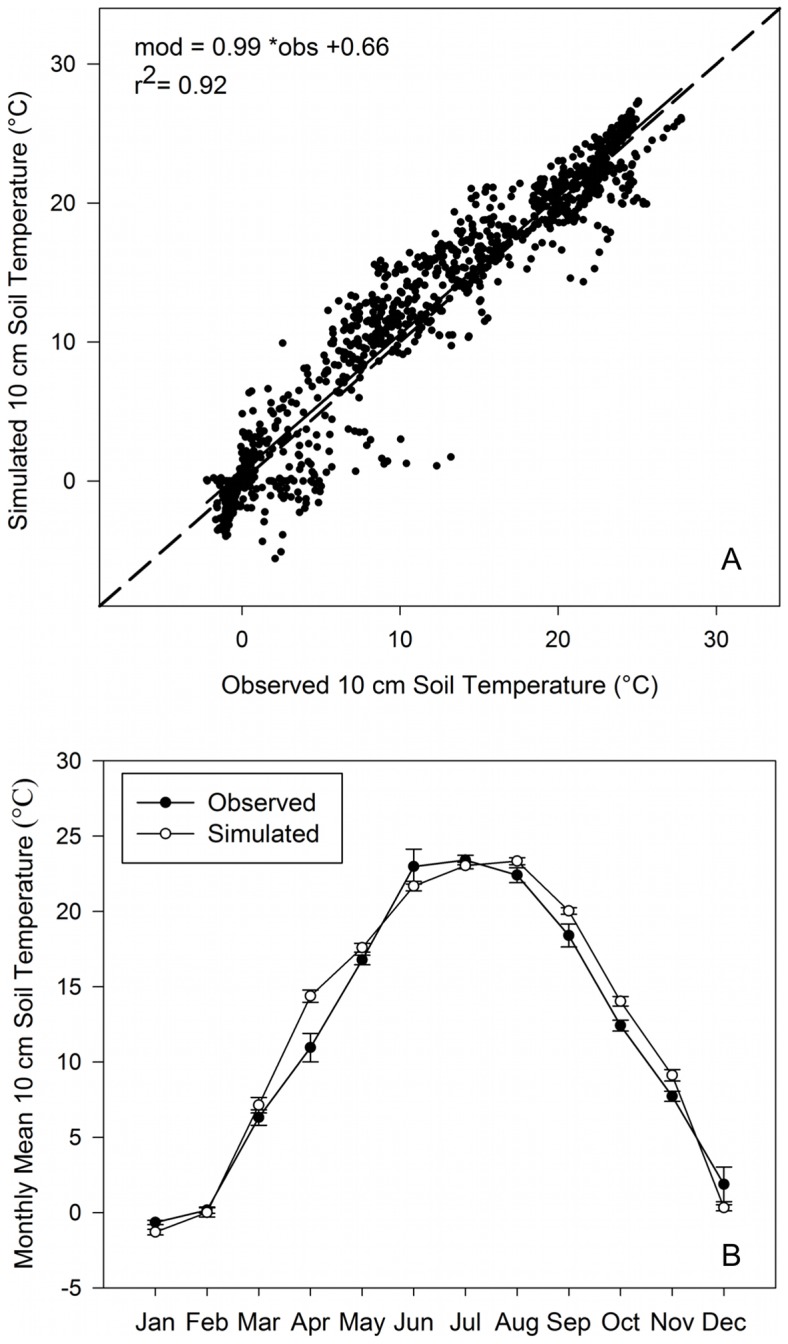
Comparison of observed and simulated soil temperatures in Illinois.(a) Comparison of 3-day running mean 10 cm soil temperatures for Agro-IBIS model simulations of miscanthus with no residue layer with observed values at the University of Illinois Energy Farm from 2009 to 2011. Observed values are the daily mean (n = 1 to 5) of observation for the miscanthus plots, n was less than five for periods when sensors were damaged, with n at least 3 for 80% of the days. (b) Comparison of monthly mean 10 cm soil temperatures for the same site and simulation. Data points are the mean (n = 3) of the 2009–20011 monthly values, error bars are ±1 S.E. for both simulated and observed values.